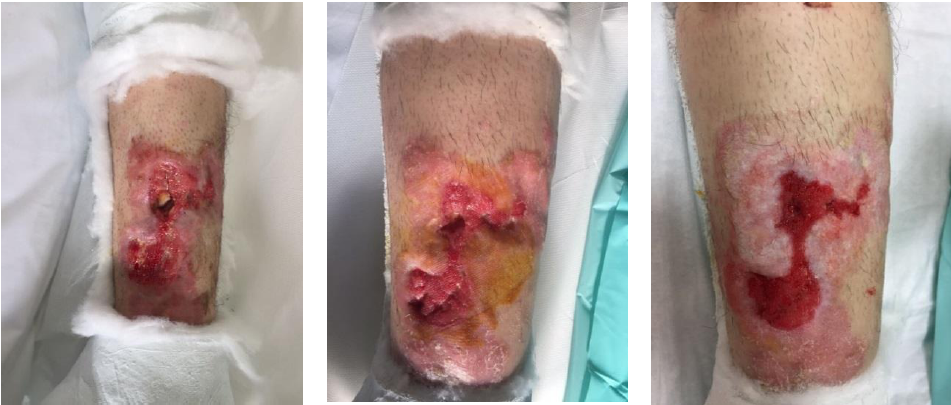
Figure 7. Condition of progressive improvement of soft tissues following vacuum-assisted closure (VAC) therapy.